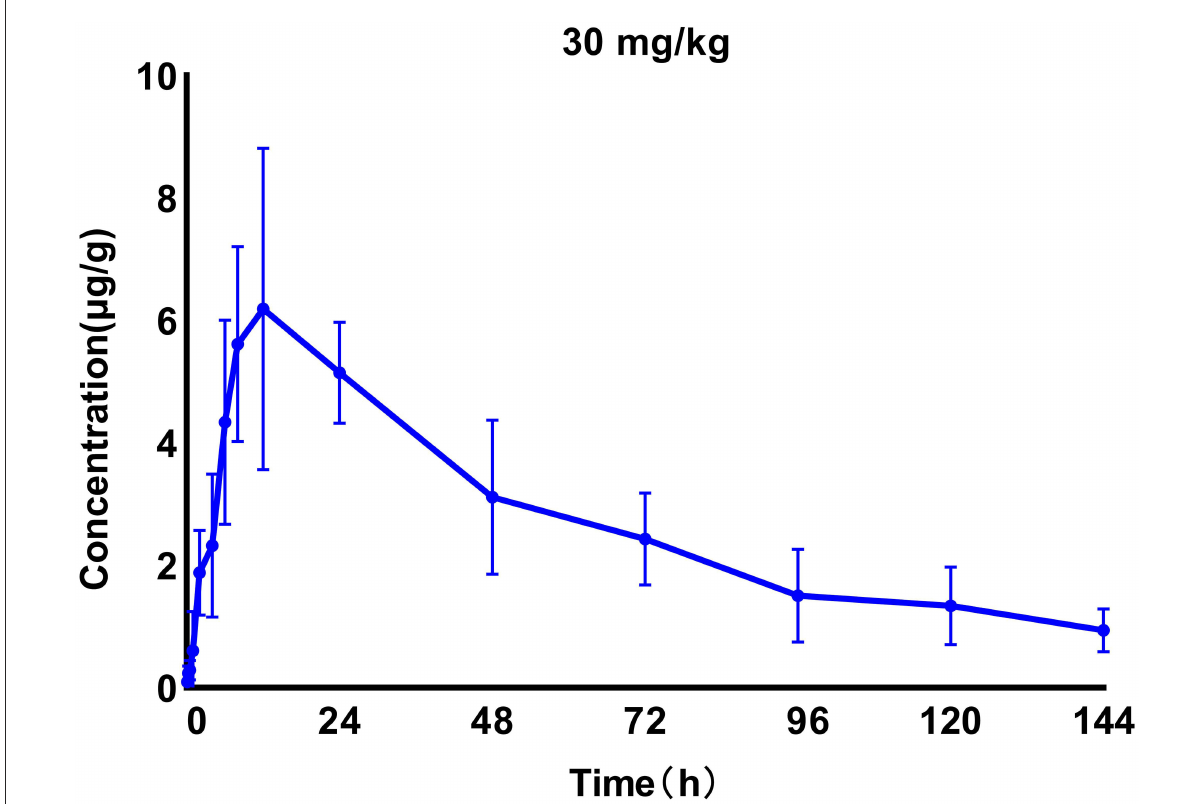
FIGURE3 Time–concentration curves of tilmicosin in lung tissues after oral administration of 30 mg/kg in M. gallisepticum -infected chickens ( n = 8/time point).